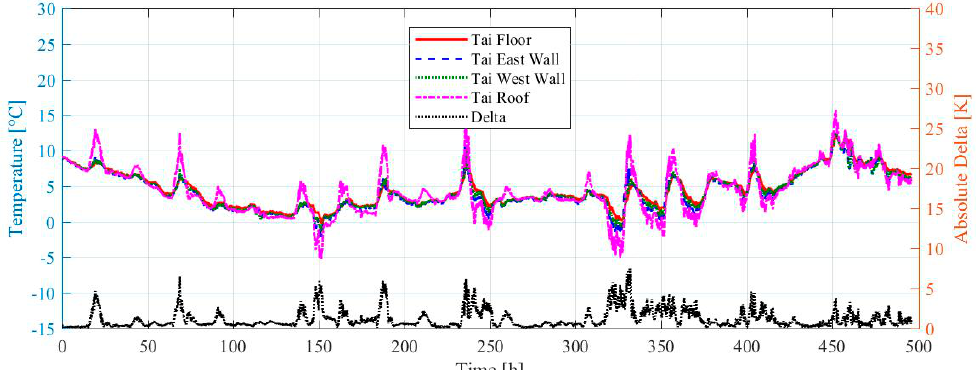
Figure 4. External air temperatures measured in front of surfaces of different orientations (left axis) with absolute delta of the four sensors (right axis).